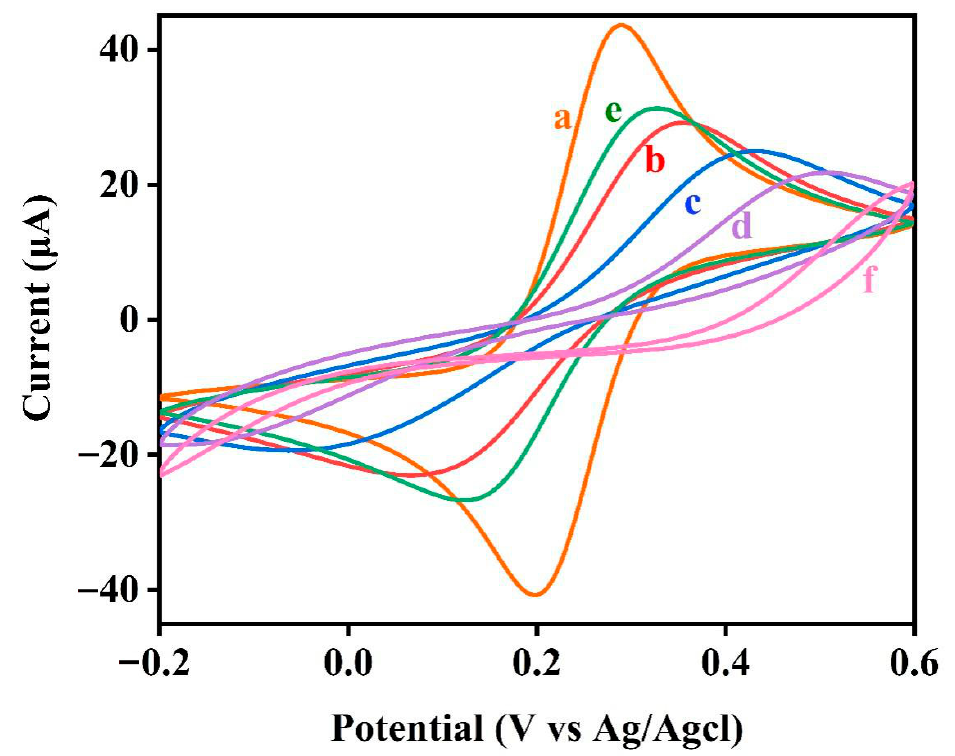
Figure 3. Cyclic voltammograms at different stages of electrode modification: ( a ) bare gold electrode, ( b ) B1-DNA, ( c ) M1- Biotin DNA, ( d ) M1-Biotin-SA DNA-modified electrode hydrolyzed by EXO III, ( e ) M1-Biotin DNA modified electrode hydrolyzed by EXO III, ( f ) M1-Biotin-SA DNA-modified electrode. The data were recorded in the presence of 5mM [Fe(CN) 6 ] 3 − /4 − containing 0.1 mol/L KCl by scanning the potential from − 0.2 V to 0.6 V at a scan rate of 100 mV/s.